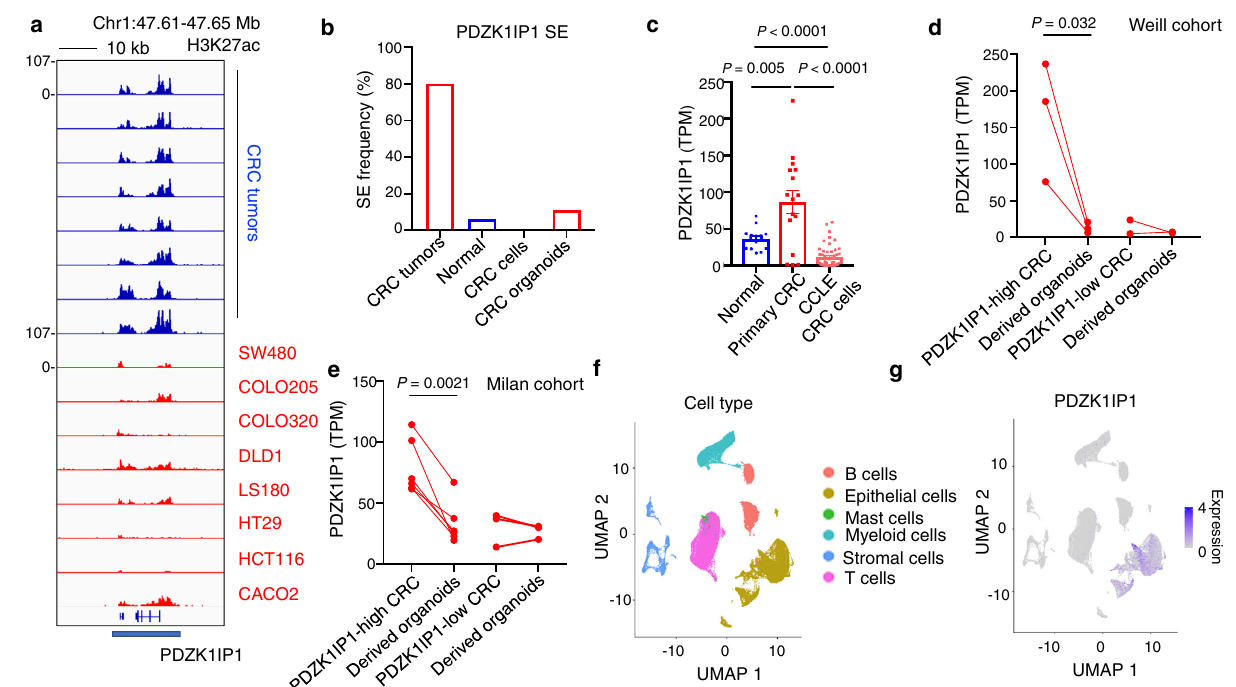
Fig. 3 | A context-dependent, primary CRC-enriched super-enhancer at the locus of PDZK1IP1 . a H3K27ac ChIP-seq tracks at the PDZK1IP1 SE in primary CRCs ( n =8 representative independent tumors) and CRC cell lines ( n =8 representative lines). The y-axes of all ChIP-seq tracks are scaled to the same range [0-107]. b Frequencyof samples meeting ROSE criteria for SE calling atthe PDZK1IP1 locus. n =15independentCRCtumors, n =15independentpatient-matchednormalcolon mucosae, n =13 independent CRC cell lines, n =9 independent 3D CRC organoids. c RNA-seq expression of PDZK1IP1 in primary CRC ( n =16 independent tumors), normalmucosa( n =15independenttissuesamples),andCCLECRCcelllines( n =51 independent cell lines). Data presented as median ± interquartile range. Sig- ni fi cancewasdeterminedusingtwo-sided Student ’ s t test. d , e RNA-seqexpression